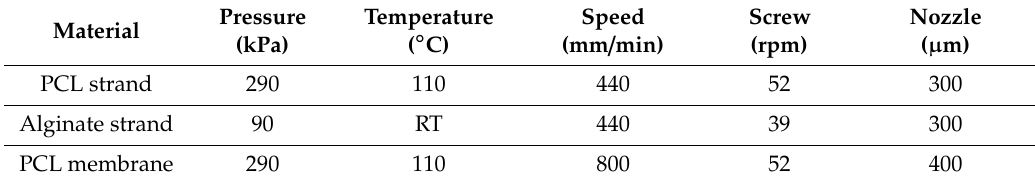
Table 3. Fabrication conditions of the hybrid and bipartite hybrid sca ff olds.